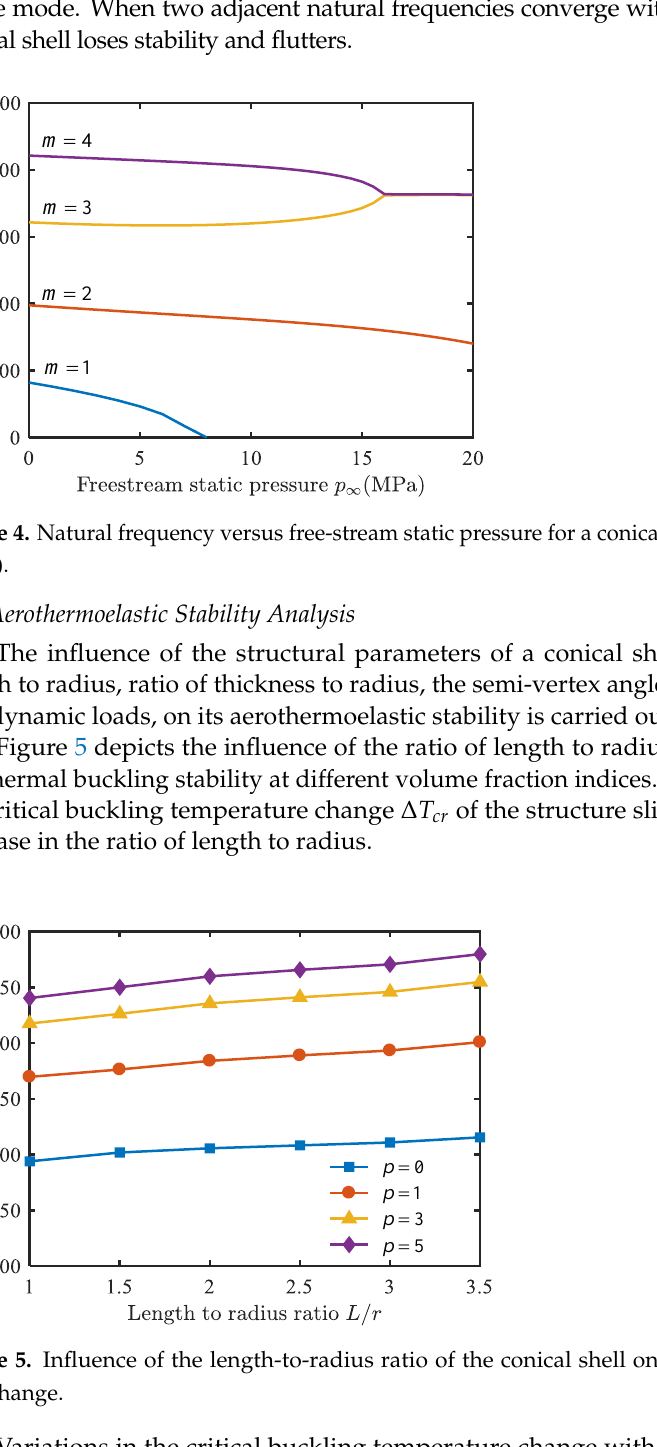
0 1 3 5 p p p p = = = = Figure 6. Influence of the thickness-to-radius ratio of the conical shell on critical buckling tempera- ture change.